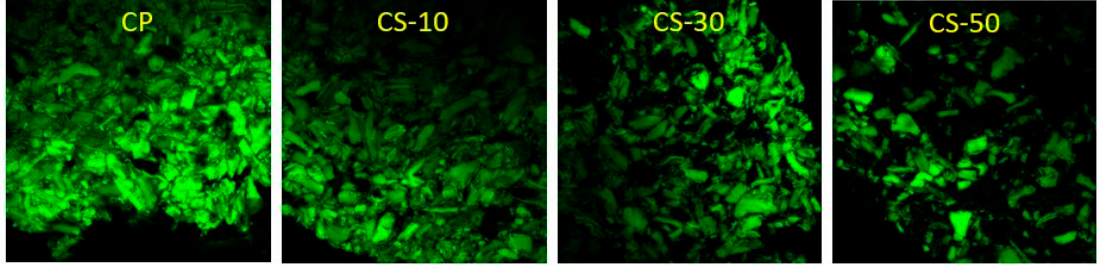
Figure 5. Confocal imaging for CP, S, CS-10, CS-30, and CS-50 after equilibration with fluorescein.